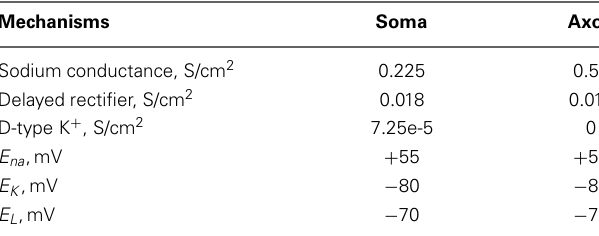
Table 4 | Active ionic properties of inhibitory interneurons.